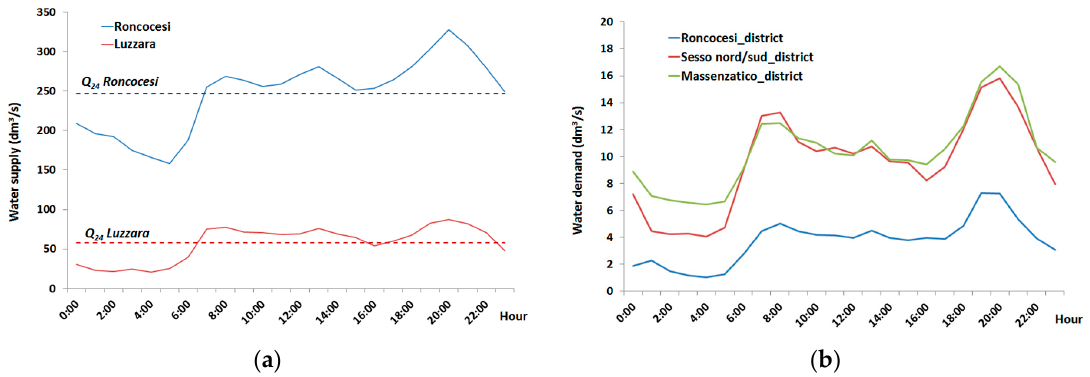
Figure 4 . ( a ) Average hourly water supply (dm 3 /s) introduced in Roncocesi and Luzzara networks by the main reservoirs; ( b ) Average hourly water demand (dm 3 /s) from Roncocesi, Sesso, and Massenzatico localities. These flows are derived over the day of highest consumption, i.e., 15 July 2013.